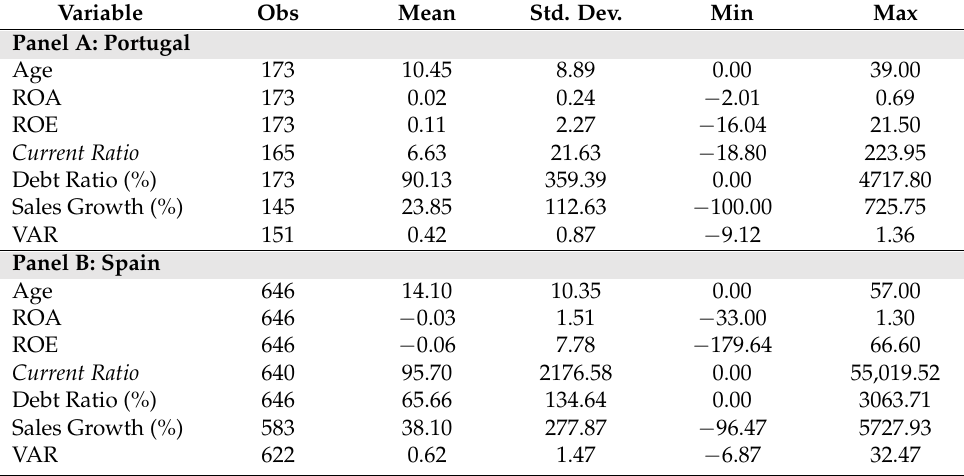
Table 3. Financial